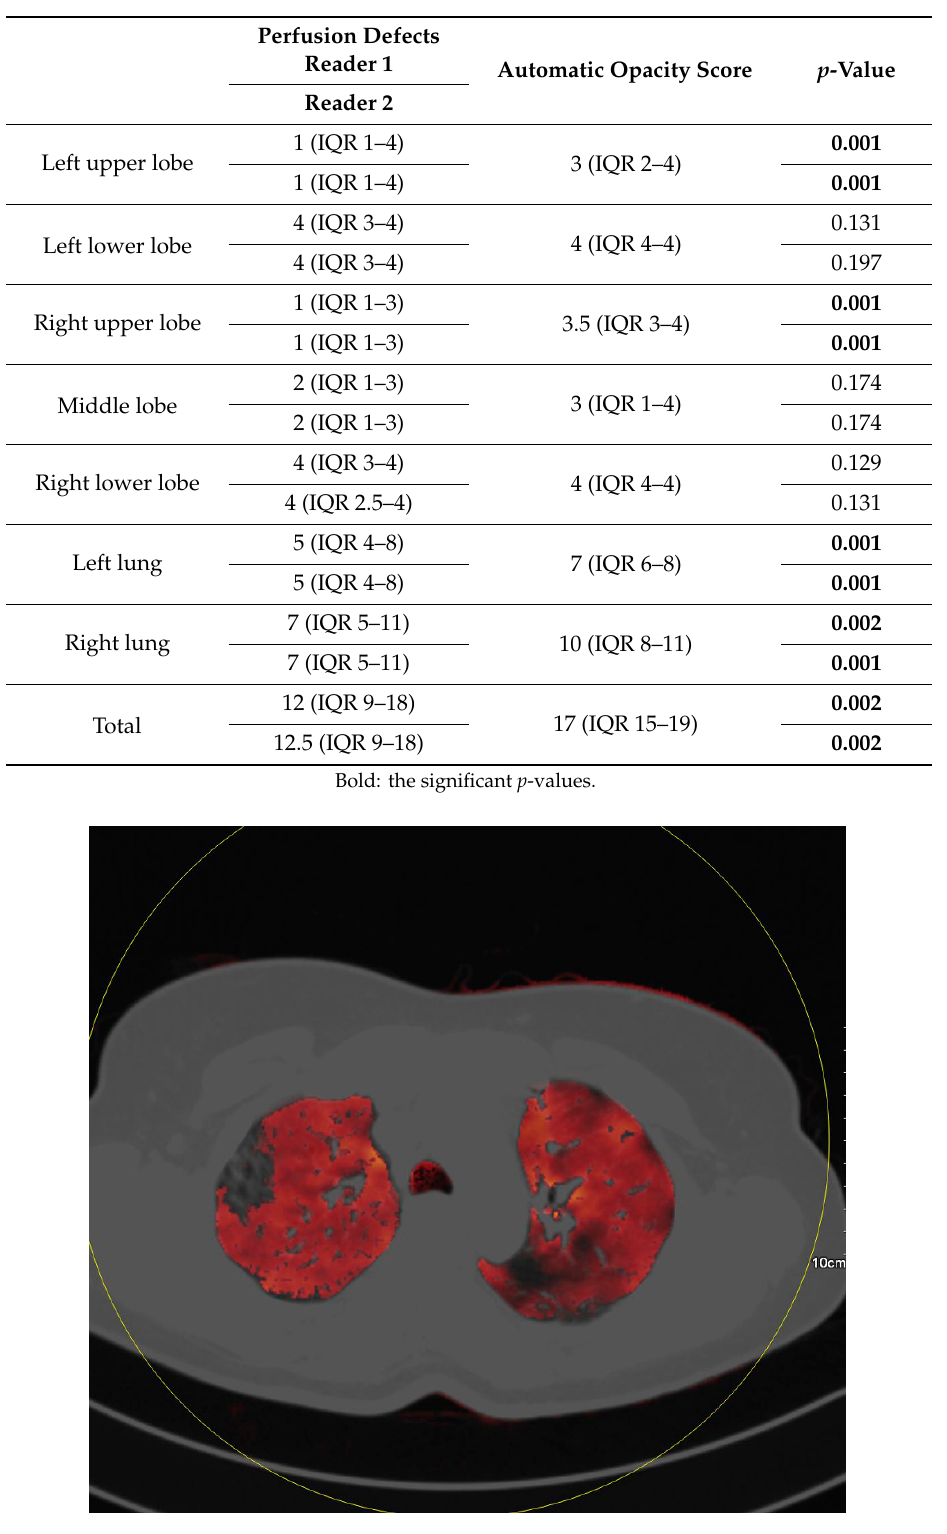
Table 5. Median (interquartile range; IQR) perfusion defect scores of readers 1 and 2 and the automatic opacity score.